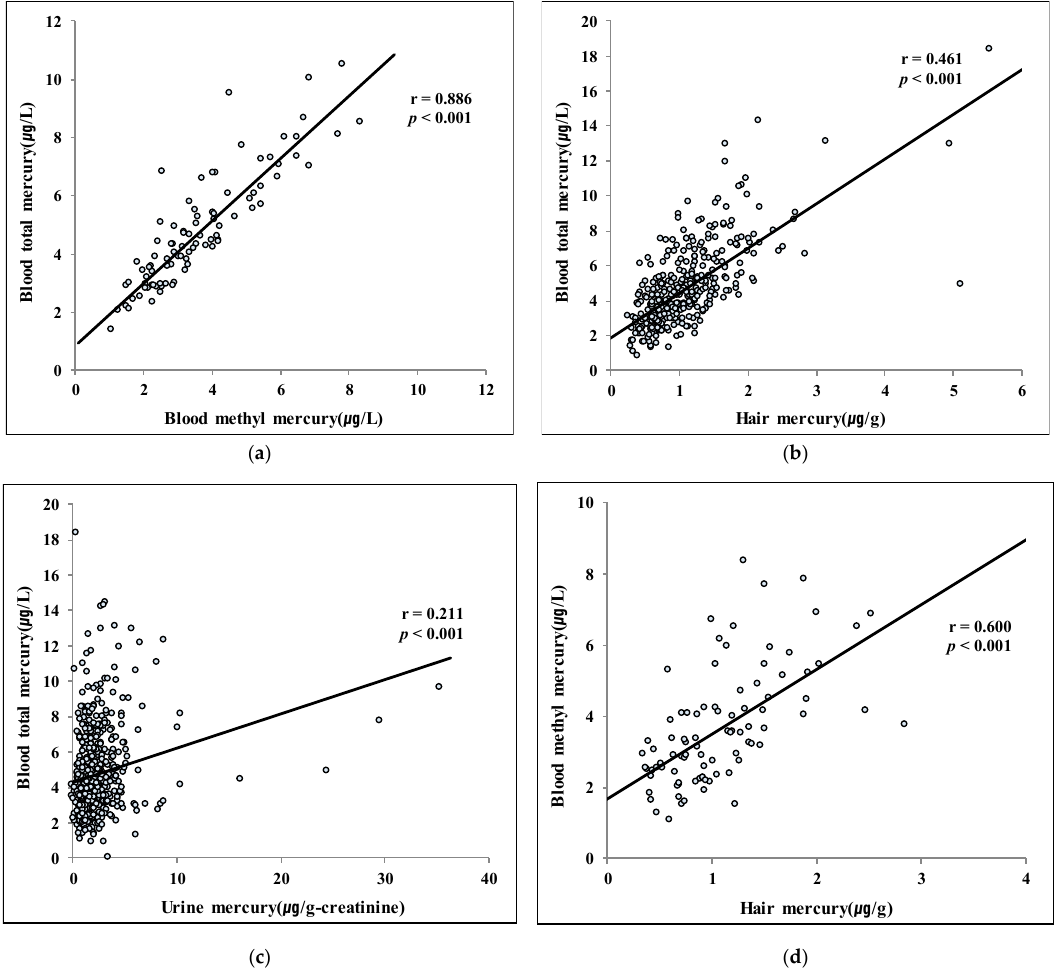
Figure 2. Correlations among mercury concentrations ( a ) Total blood mercury and blood methyl mercury; ( b ) Total blood mercury and hair mercury; ( c ) Total blood mercury and urine mercury; ( d ) Blood methyl mercury and hair mercury.